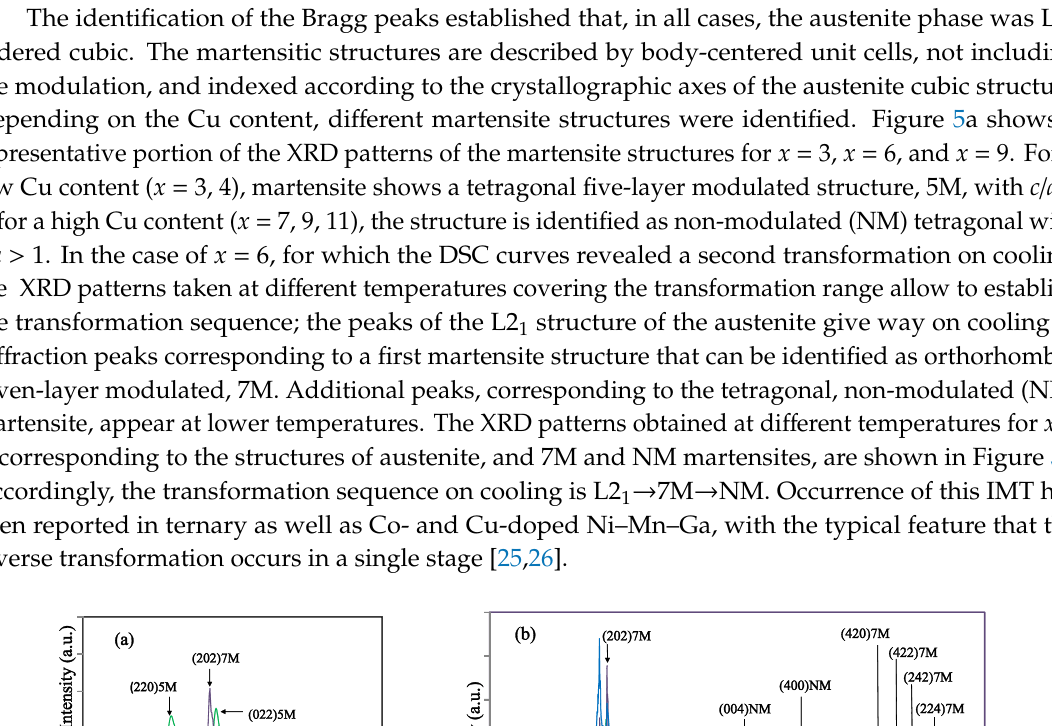
Figure 4. Absolute values of the transformation entropy changes, for the forward and reverse MTs, together with the thermal hysteresis computed as Δ T = A P − M P , as a function of Cu content. The identification of the Bragg peaks established that, in all cases, the austenite phase was L2 1 ordered cubic. The martensitic structures are described by body-centered unit cells, not including the modulation, and indexed according to the crystallographic axes of the austenite cubic structure.